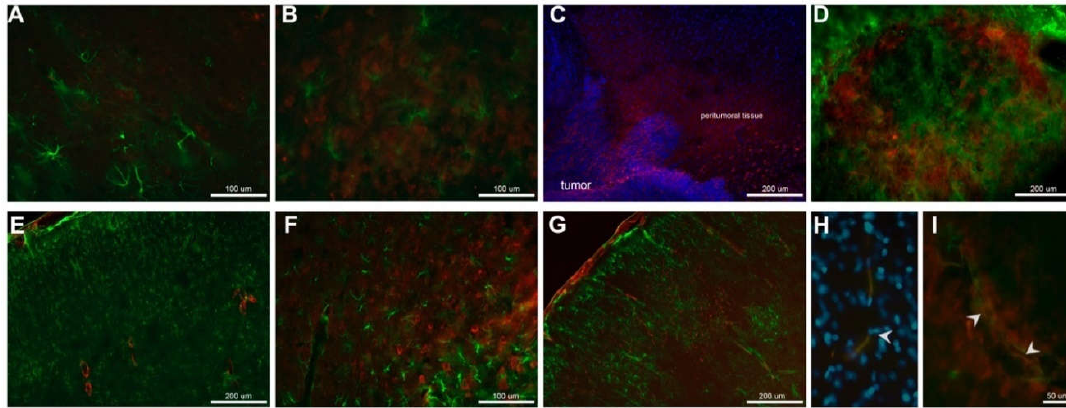
Figure 4. Brain CYP2B1 protein localization. Double immunofluorescence for CYP2B1 (red) and GFAP (green) was performed ( A – G ). CYP2B1 was mainly expressed in neuronal cells in healthy brain tissue ( A ) and nicotine treatment increased its expression ( B ). CYP2B1 was highly expressed in tumor cells and peritumoral tissue , nuclei were counterstained with DAPI ( C ). High detection of the enzyme was found in the glioma and not in cells expressing GFAP ( D ), the tissue away from the tumor did not express CYP2B1 ( E ). Nicotine treatment did not increase CYP2B1 expression in tumor cells ( F ); however, it increased CYP2B1 expression in the vicinity of the tumor, along blood vessels ( G ). Finally, blood vessels were identified with von Willebrand protein (green) and its co-location (yellow) with CYP2B1 is shown (arrows) in normal ( H ) and tumor vessels ( I ).